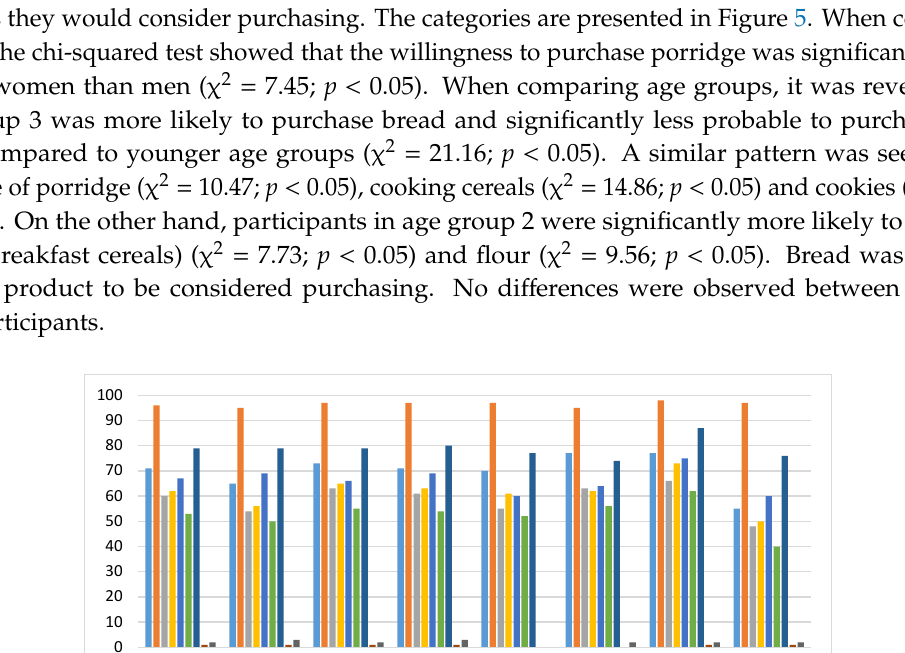
Figure 6. Preference of purchasing sites for heritage cereal products in the future. The category “Others” included the following options: Delivery to home/to work, REKO-ring, on-line/online store, directly from producer/grower, café, farm shop, bake yourself and market. Figure 7. Frequency in percentages showing willingness to pay more for heritage cereal products. 5. Discussion This study shows a great consumer interest in heritage cereals, where almost all consumers would consider purchasing bread or other products based on heritage cereals. This may be explained by the health trends and their relation to heritage cereals [32]. Furthermore, this great interest is well